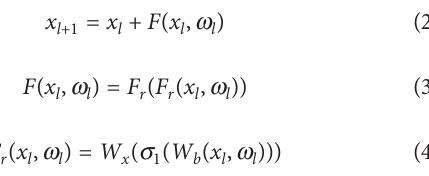
TABLE 1 | The results of comparative experiments with or without dropout in the SE module on the BraTS 2020.